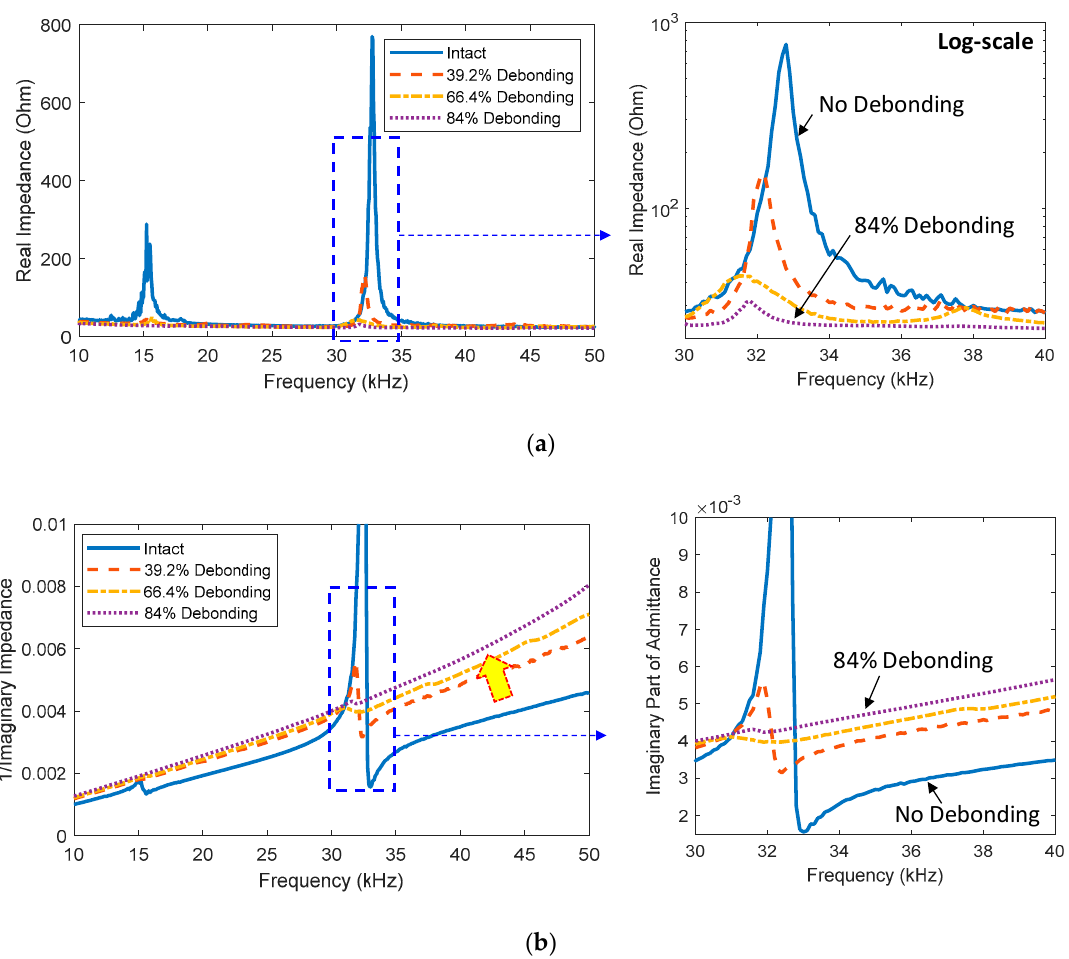
Figure 3. Measured impedance signatures under the sensor debonding cases: ( a ) real part; ( b ) imaginary part.